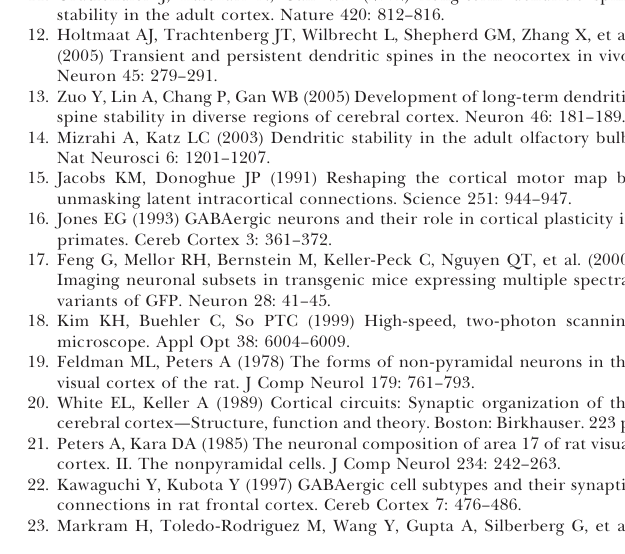
Figure S1. Layer Localization of Imaged Neurons and Distribution of GABAergic Subtypes (A and C) Neurons shown in Figure 6 were in layer 2/3 as shown by DAPI staining (B and D) (border of layer 1 and layer 2/3 delineated by empty arrowheads). (E) GFP labeling of non-pyramidal cells in layers 1 and 2/3 shows a representative distribution of GABAergic, parvalbumin, somatostatin, and cholecystokinin immunopositive cells. Solid bars represent percent of layers 1/2/3 GFP-labeled non- pyramidal cells immunopositive for a given marker, and empty bars represent percent of all GABA-positive cells immunopositive for the same markers. Error bars represent SEM. Scale bar (A–D): 50 l m. Found at DOI: 10.1371/journal.pbio.0040029.sg001 (5.8 MB TIF). Figure S2. Histogram of the Number of Monitored Branch Tips for Different Branch Lengths of Pyramidal and Non-Pyramidal Cells Found at DOI: 10.1371/journal.pbio.0040029.sg002 (837 KB TIF). Figure S3. Histogram of the Number of Remodeling Events in Non- Pyramidal Neurons as a Function of Distance from the Cell Soma Found at DOI: 10.1371/journal.pbio.0040029.sg003 (899 KB TIF). Protocol S1. Analysis of the Dendritic Change Propensities for Non- pyramidal and Pyramidal Neurons Found at DOI: 10.1371/journal.pbio.0040029.sd001 (47 KB DOC). Video S1. Z -Stack of Pyramidal Cell ‘‘ dow ’’ Descending at 1.5- l m Steps Found at DOI: 10.1371/journal.pbio.0040029.sv001 (1.4 MB WMV). Video S2. Z -Stack of Non-Pyramidal Cell ‘‘ nmr ’’ Descending at 1.5- l m Steps Found at DOI: 10.1371/journal.pbio.0040029.sv002 (862 KB